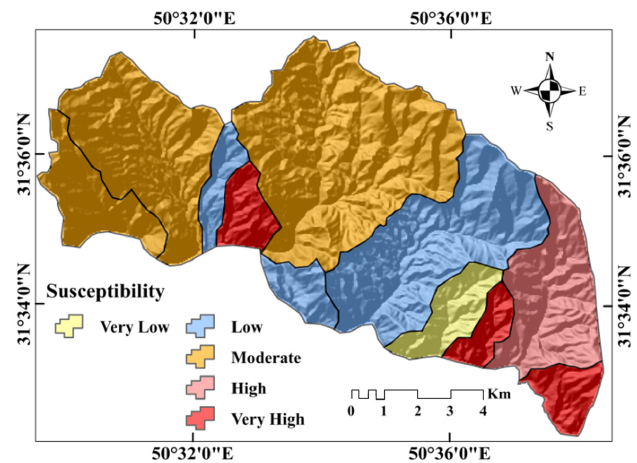
Figure 9. Prioritization of sub-basins for conservation programs.